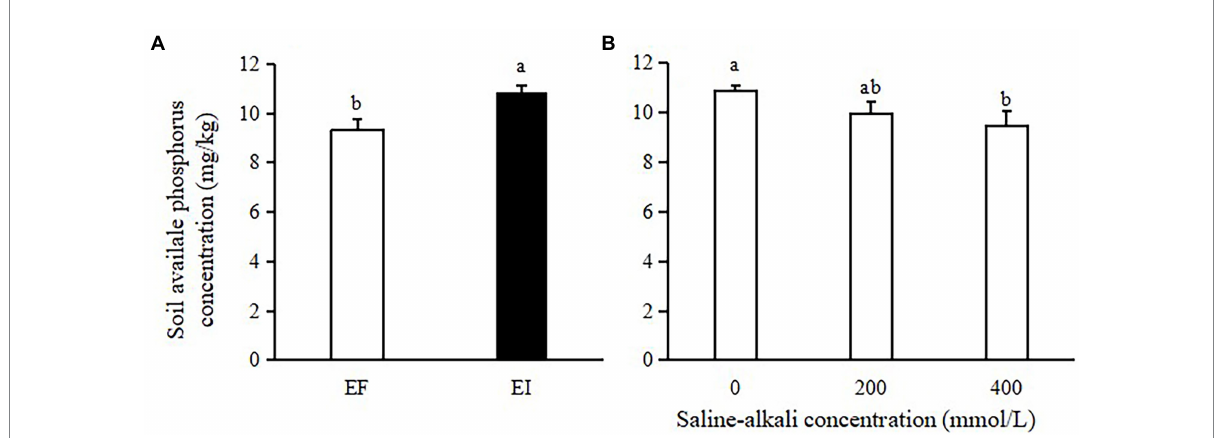
FIGURE 1 Effects of Epichloë endophyte (A) and saline-alkali stress (B) on soil available phosphorus concentration. Values are means ± SE. Different letters denote means that are significantly different ( p <